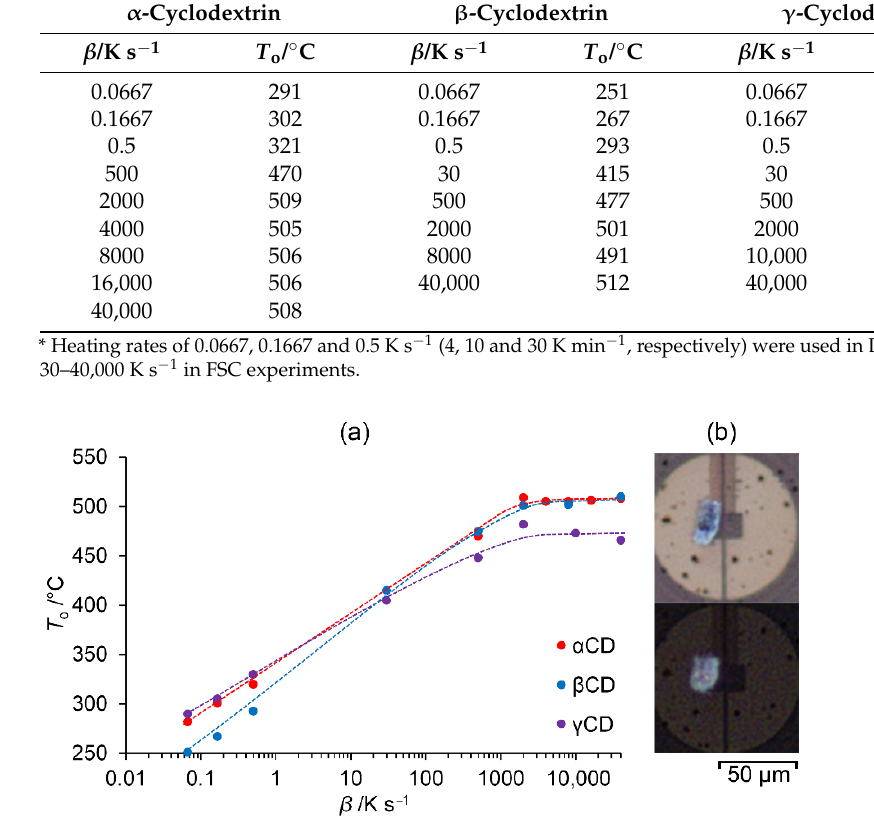
Table 1. Onset temperatures ( T o ) of main endothermic peak for anhydrous natural cyclodextrins at different heating rates ( β ) *. α -Cyclodextrin β -Cyclodextrin γ -Cyclodextrin